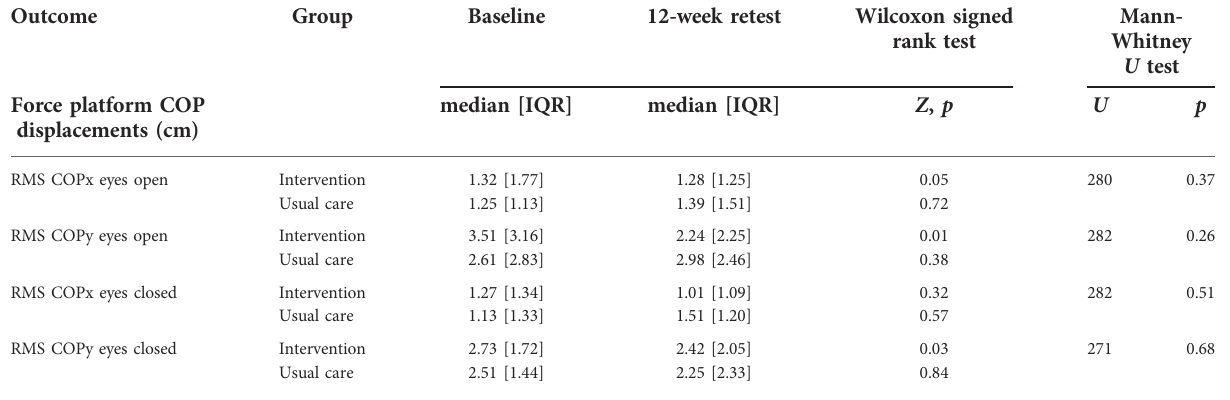
TABLE 5 Force platform data. Within- and between-group changes.